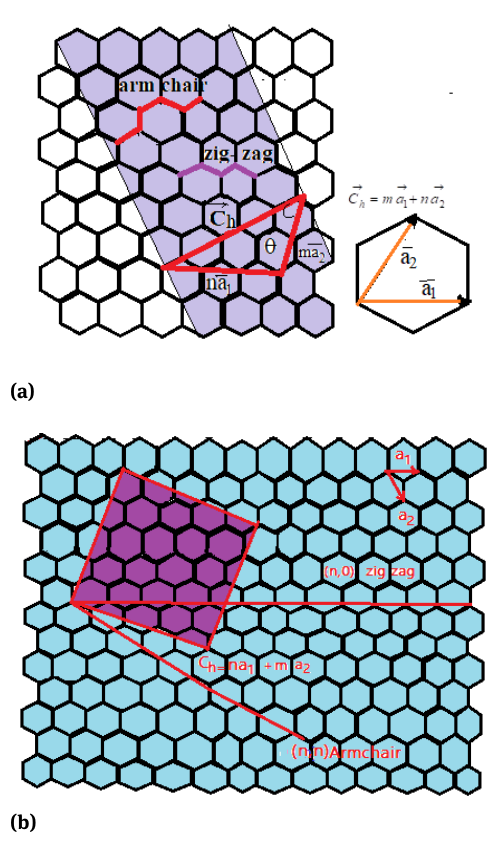
Figure 1: (a) Geometric properties of a SWCNT (b) Graphene struc- ture for a CNT